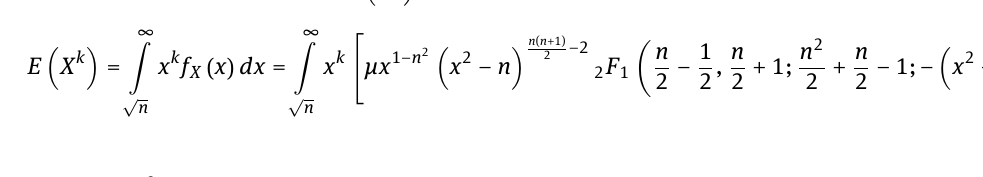
Figure 4: Plot of the hazard rate function, h ( x ) , for n = 2 , Eq. (2.1), we derive the moment, E